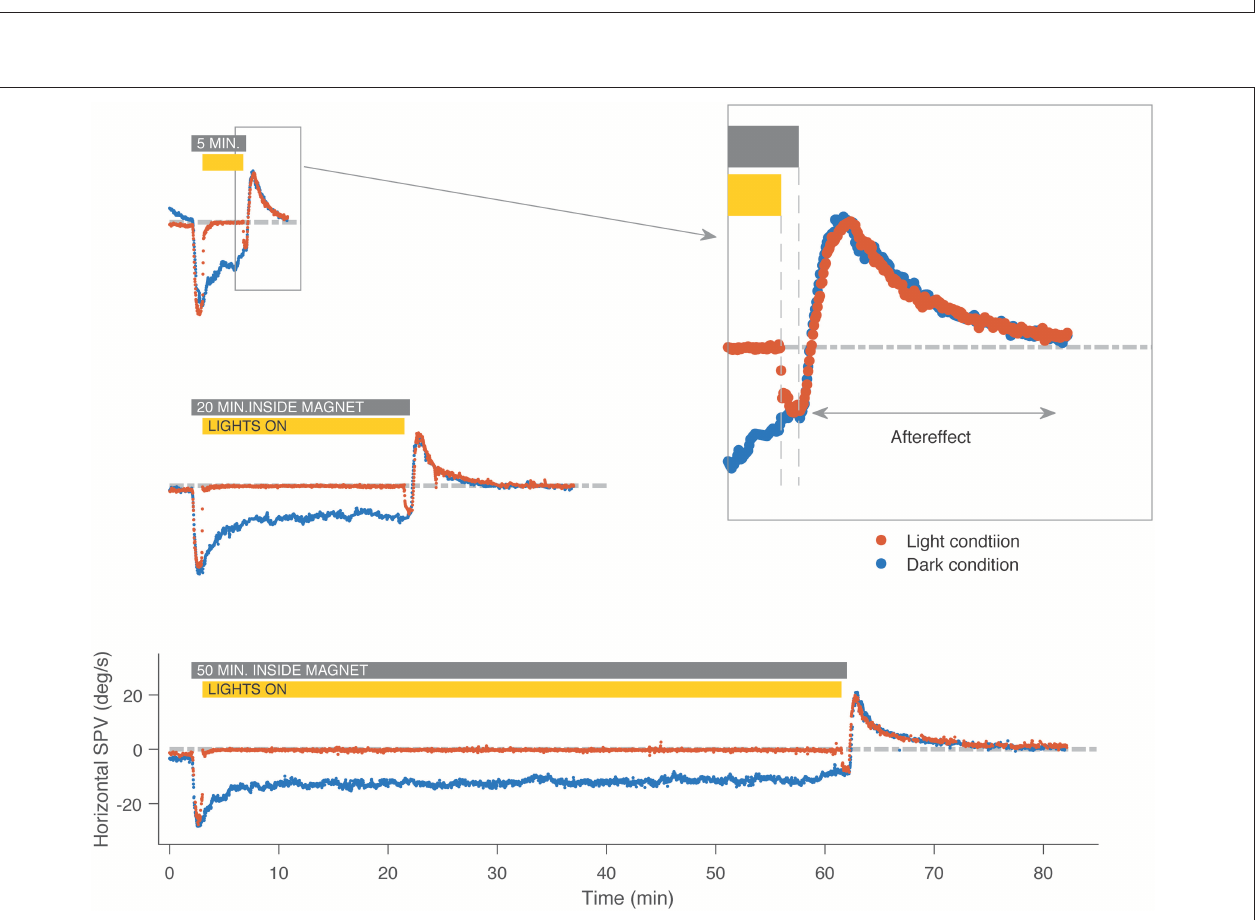
FIGURE 2 | An example subject’s horizontal slow-phase nystagmus eye velocity in the MRI. The blue traces represent trials in darkness without visual fixation and the red represent trials where the subject enters the MRI in darkness, lights are turned on for visual fixation, and then turned off before exiting from the MRI. In darkness, a pattern of first fast then slow adaptation occurs, followed by an after effect in the opposite direction. Aside from the period of visual fixation, the slow-phase velocity is similar, regardless of whether lights were on or off, or of the duration in the MRI. Gray bar indicates the time the subject was inside the magnet for both trials in darkness and with visual fixation, and yellow bar indicates duration of exposure to visual fixation in the light for trials with fixation only. SPV, slow-phase eye velocity.